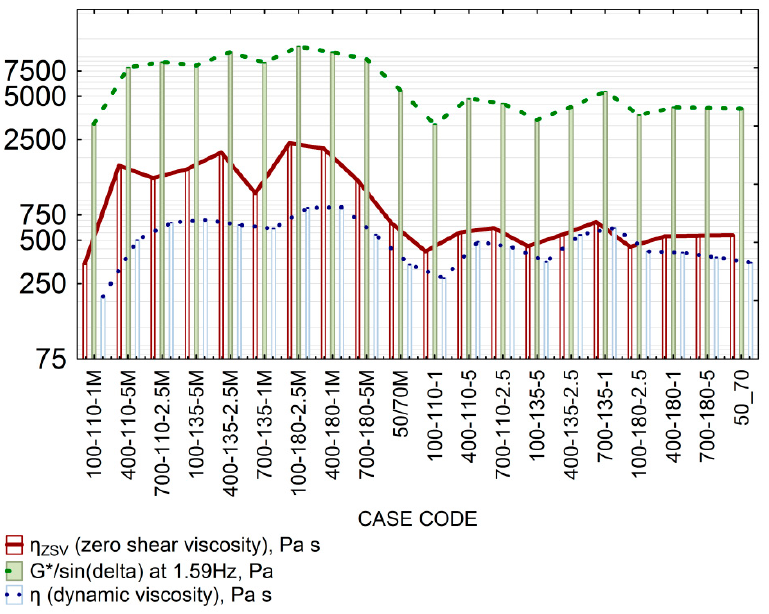
Figure 8. Foaming process (mean values) influence on the dynamic viscosity η , zero shear viscosity η ZSV and G*/sin( δ ) at 60 °C.